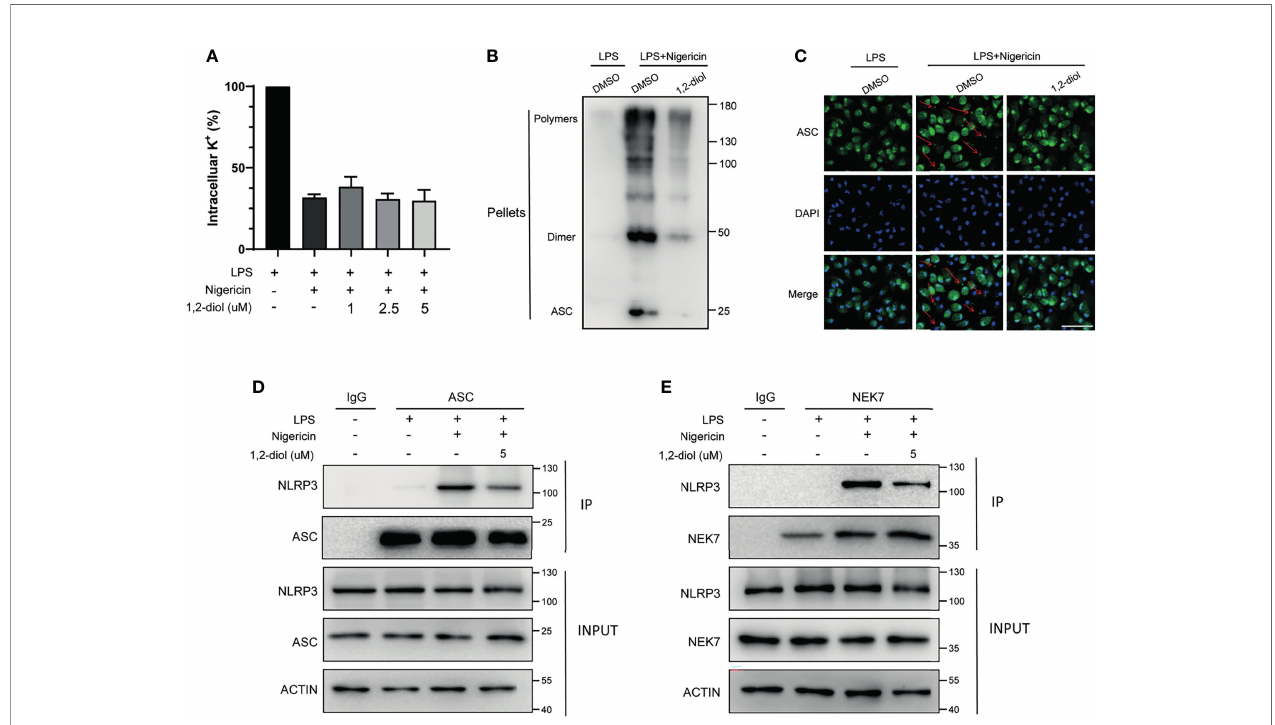
FIGURE 3 | 1,2-diol inhibits ASC oligomerization and in fl ammasome assembly (A) Quali fi cation of potassium ef fl ux in LPS-primed peritoneal macrophages treated with different doses of 1,2-diol and then stimulated with nigericin. (B) Immunoblot analysis of ASC oligomerization in the cell lysates of LPS-primed peritoneal macrophages treated with 1,2-diol and then stimulated with nigericin. (C) Immuno fl uorescent staining of ASC and representative images of ASC speck. (D) IP and immunoblot analysis of the interaction of NLRP3 and ASC in the cell lysates of LPS-primed peritoneal macrophages treated with 1,2-diol and then stimulated with nigericin. (E) IP and immunoblot analysis of the interaction of NLRP3 and NEK7 in the cell lysates of LPS-primed peritoneal macrophages treated with 1,2-diol and then stimulated with